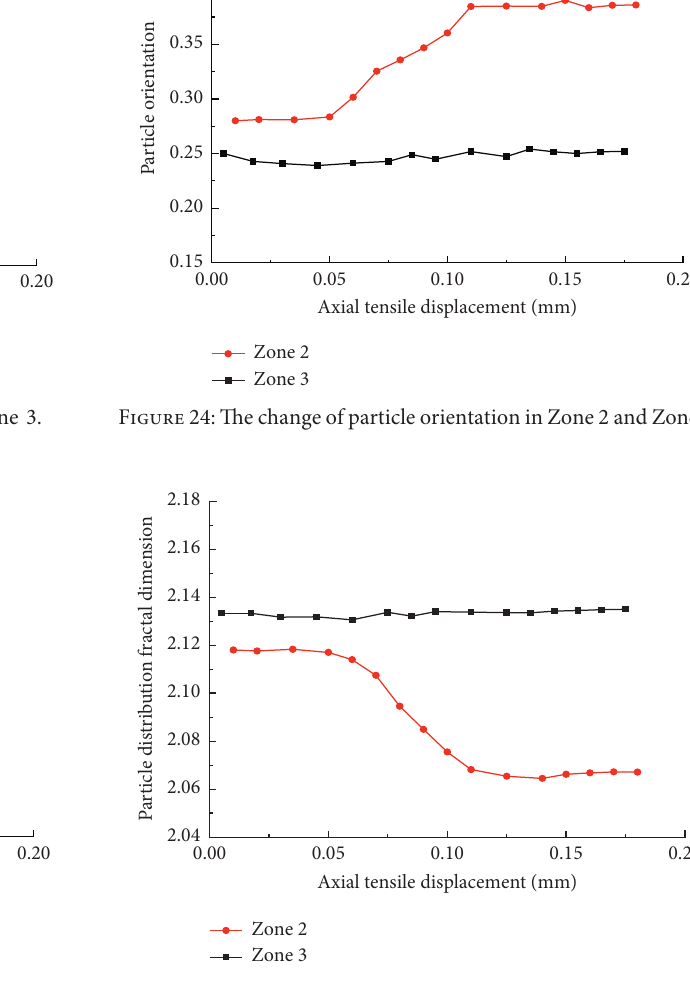
Figure 25: The change of particle distribution fractal dimension in Zone 2 and Zone